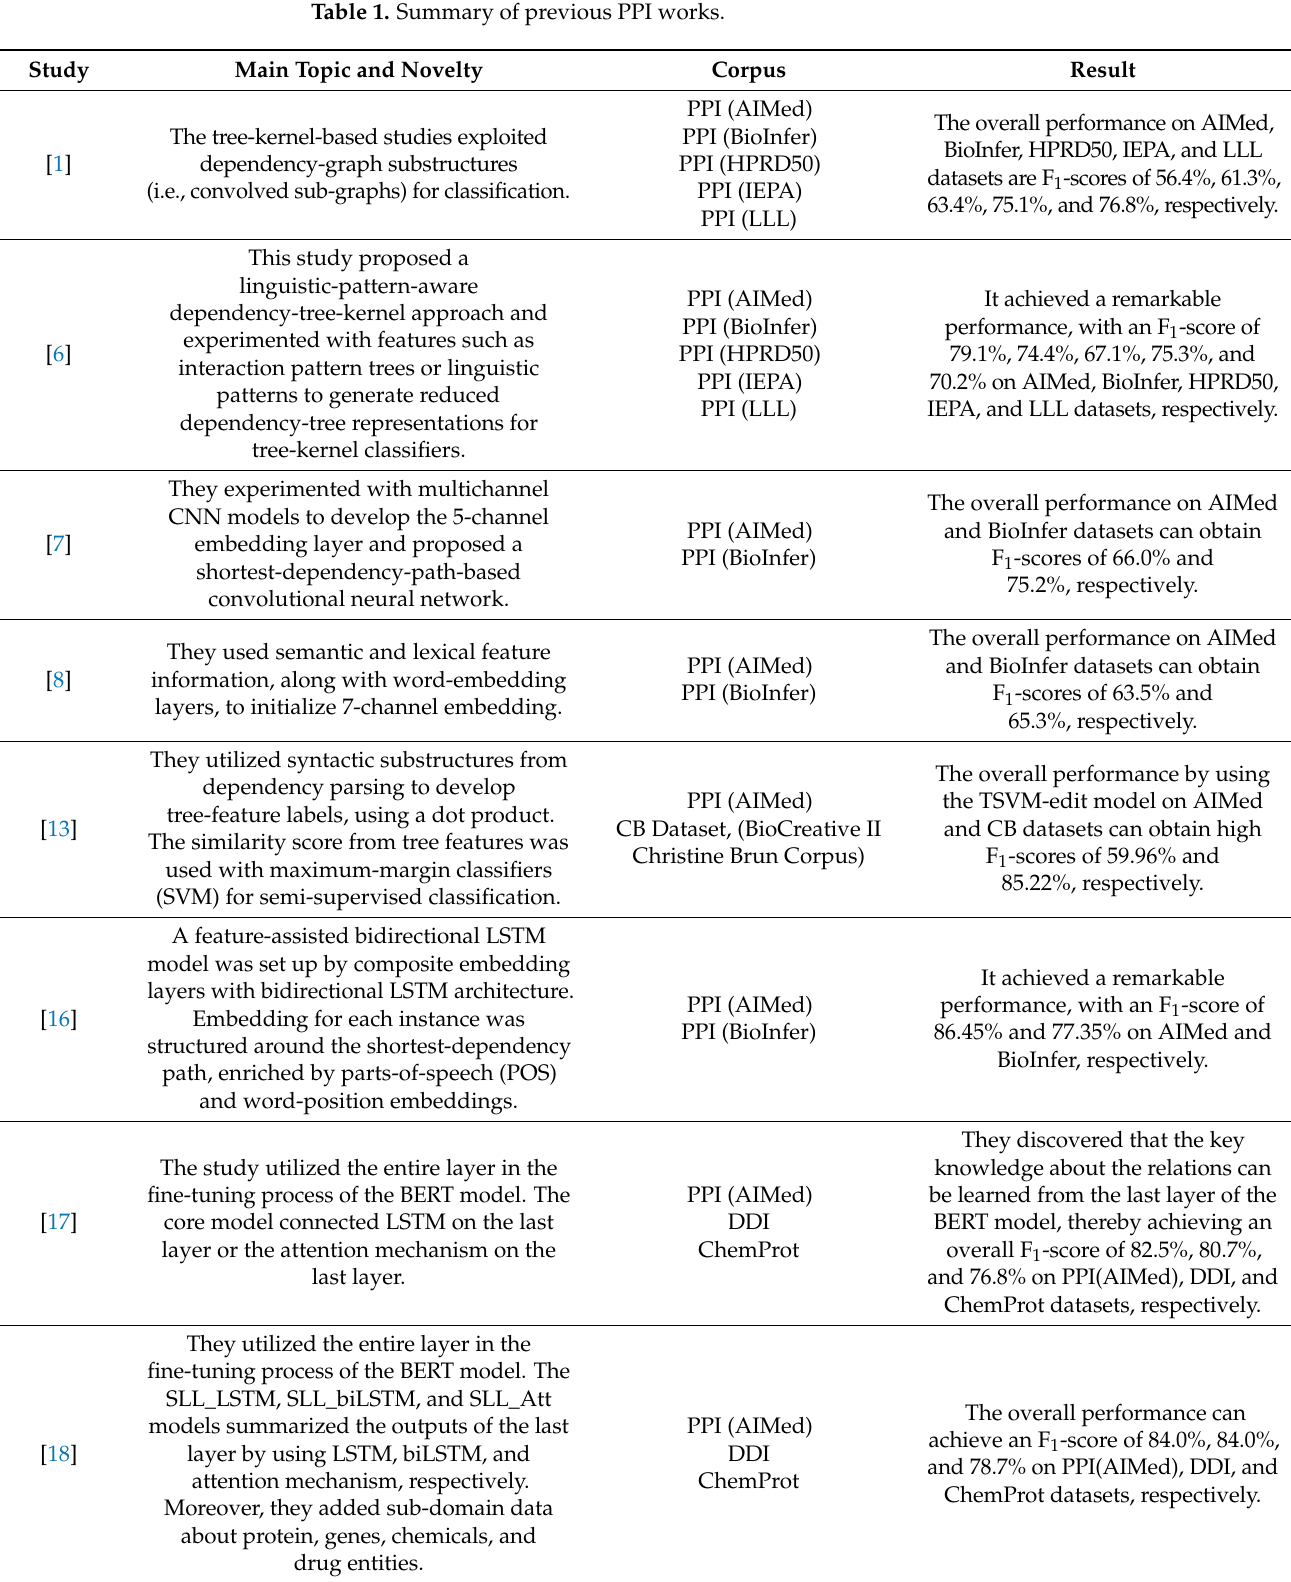
Table 1. Summary of previous PPI